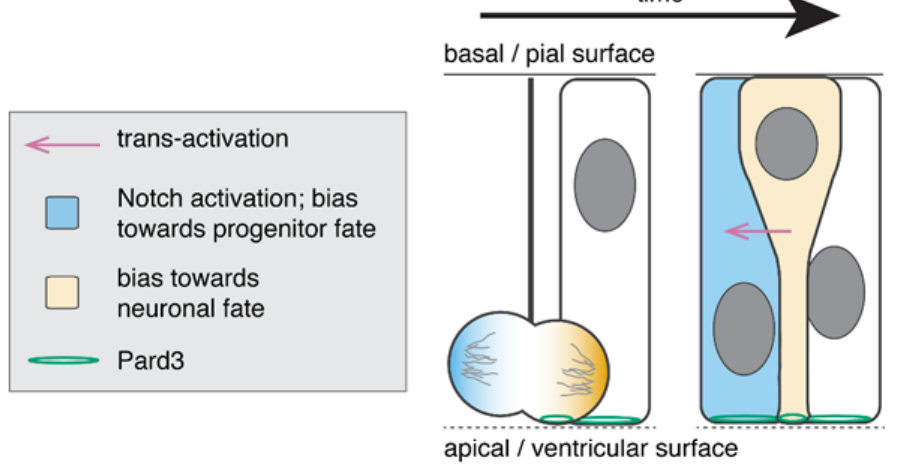
Figure 1. Recently born neurons may influence the fate of sister cells. Neural progenitors are polarised along the apico-basal axis of the neuroepithelium and localise apical polarity proteins such as Pard3 to the apical surface. Most neural progenitors divide at the apical surface of the neuroepithelium. A daughter that inherits the apical attachment (outlined by Pard3), inherits the Delta modulator Mindbomb and is likely to become a neuron. The daughter that transiently loses the apical attachment but retains the basal attachment is likely to remain a progenitor. Current evidence suggests that the neuronal daughter activates Notch signalling in its sister cell, promoting progenitor fate. However, exactly whether and when this occurs is not yet clear.